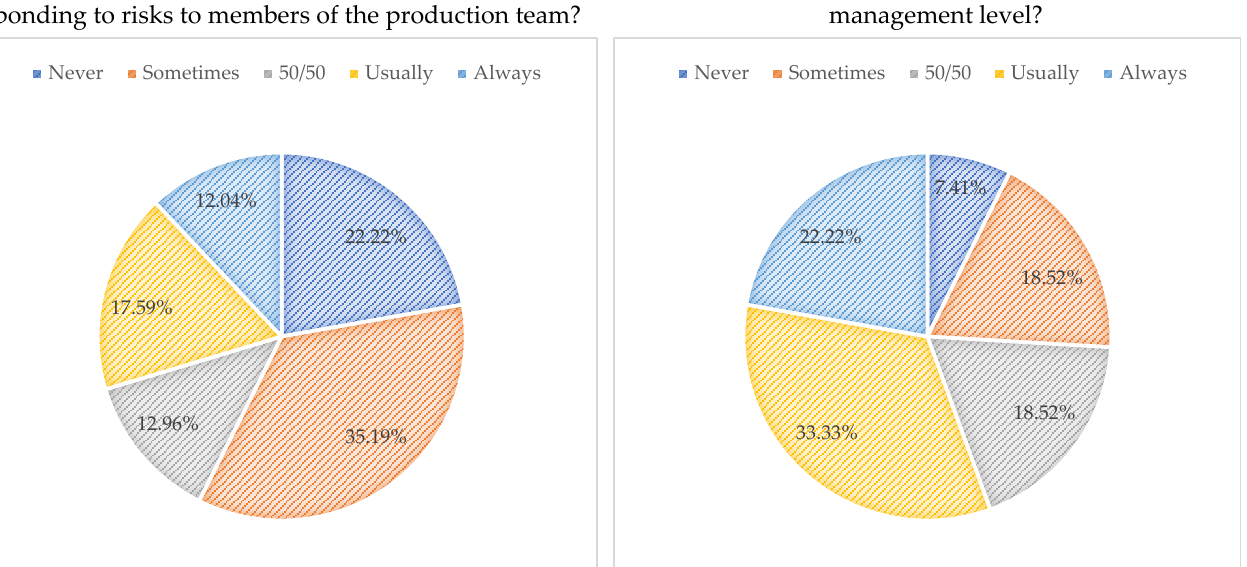
Figure 3. Risk management during project implementation (n = 89).